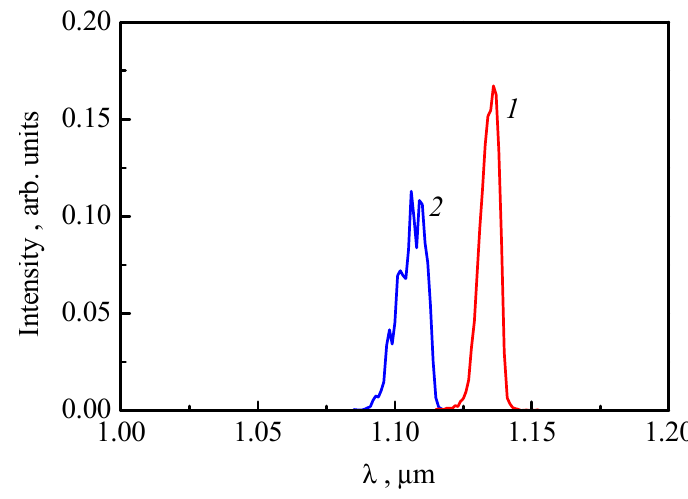
Figure 10. Stimulated emission spectra from the structures G (1) and H (2).